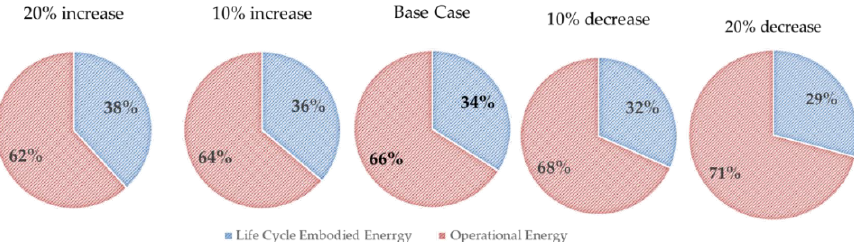
Figure 8. Proportion of Operational energy and Life cycle embodied energy based on variations in life cycle embodied energy (Scenario 3).